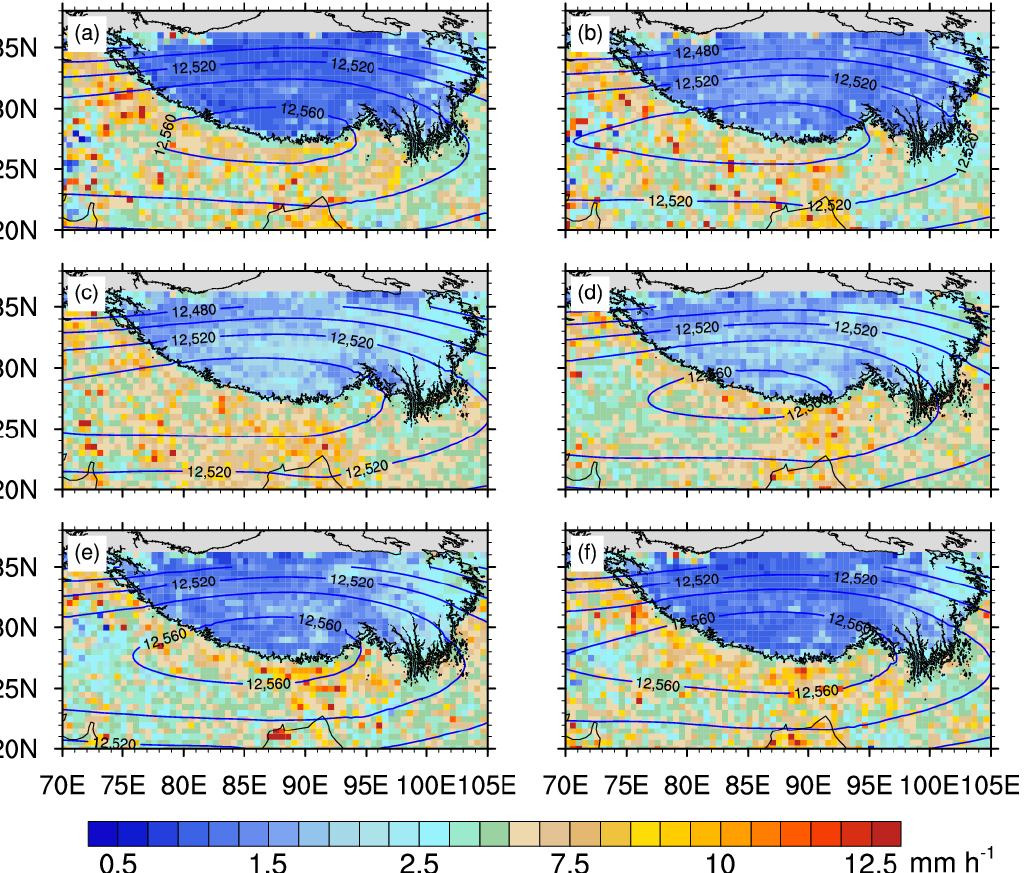
Figure 9. The distribution of mean rain rate for DCP in ( a ) early morning, ( b ) forenoon, ( c ) noon, ( d ) afternoon, ( e ) evening, and ( f ) midnight in summer over the QTP and its southern regions calculated from observations of TRMM PR from 1998 to 2012. The overlapped contours are geopotential height at 200 hPa in each time period. Note: This is the same as in Figure 6.